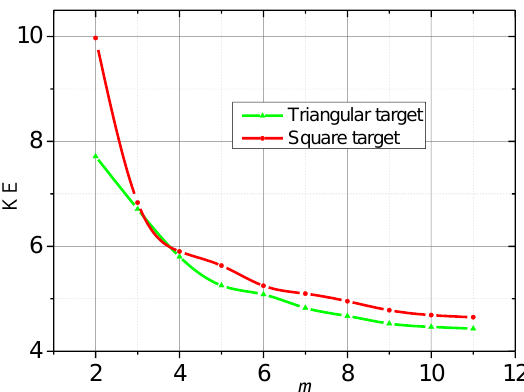
Figure 10. Relation curve between the Kolmogorov entropy (KE) and embedding dimension for the triangular and square targets.